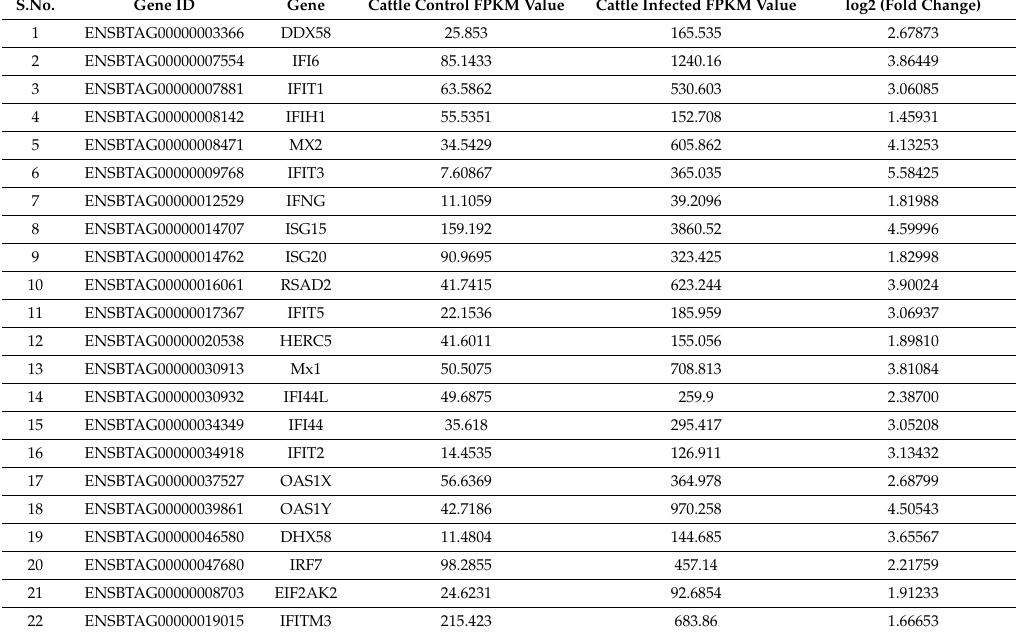
Table 6. The selected di ff erentially expressed transcripts playing a role in innate immune response and host defense to virus in the Control vs. PPRV infected cattle (Cattle PBMC). S.No. Gene ID Gene Cattle Control FPKM